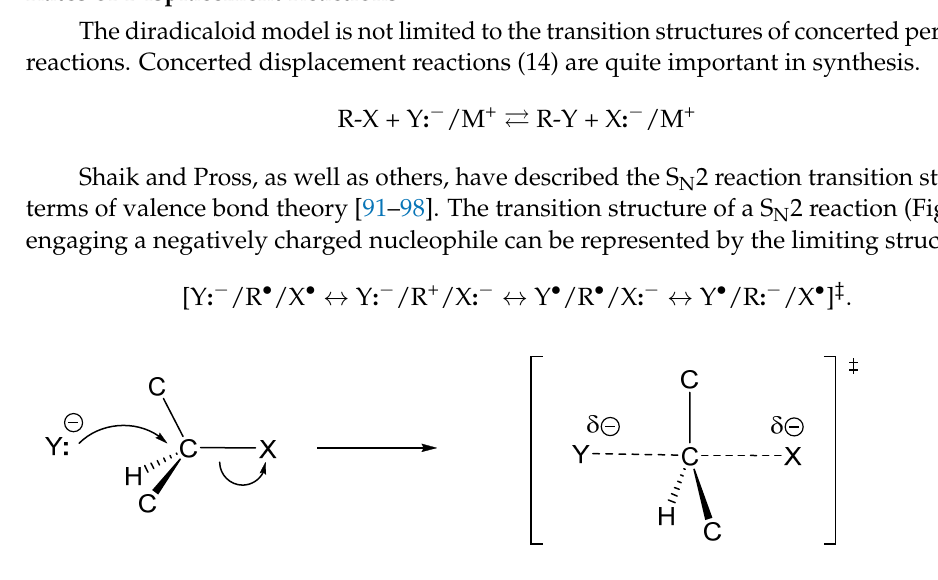
Figure 7. Classical representation of the transition state of a S N 2 displacement reaction.